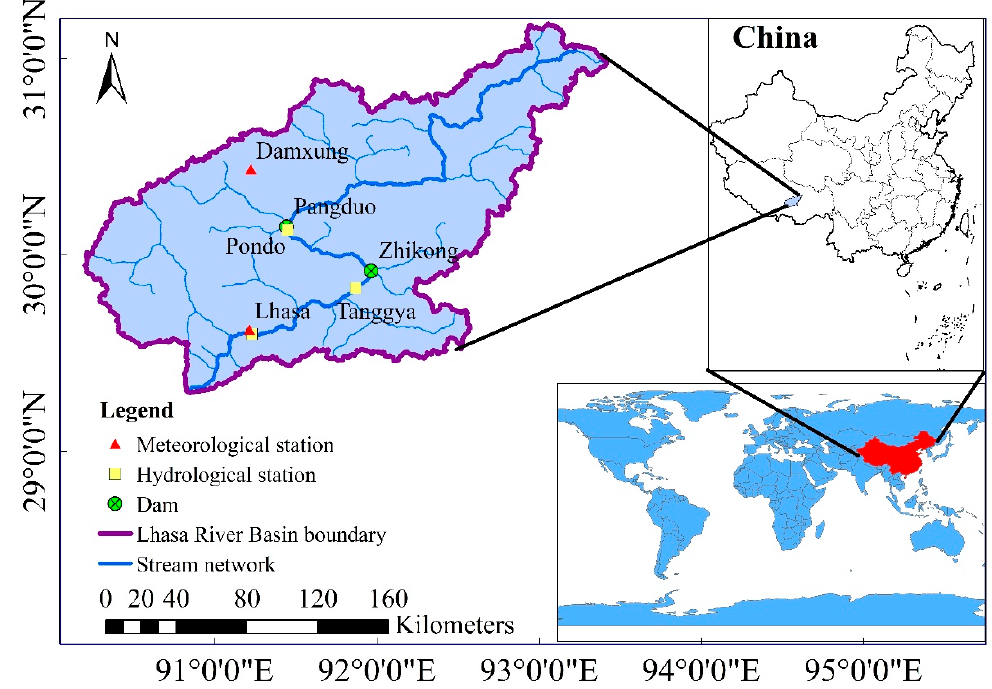
Figure 3. Location of the Lhasa River Basin and distribution of hydro-meteorological stations. Table 2. Runoff and precipitation for each month at the Lhasa Hydrological Station and the Lhasa Meteorological Station